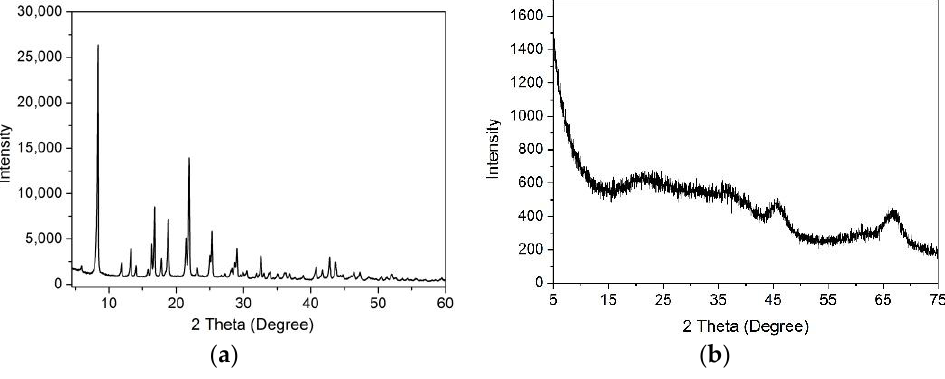
Figure 1. XRD patterns of ( a ) Al-MOFs precursor and ( b ) the obtained γ-Al 2 O 3 . Table 1. Chemical analysis of the obtained alumina samples.